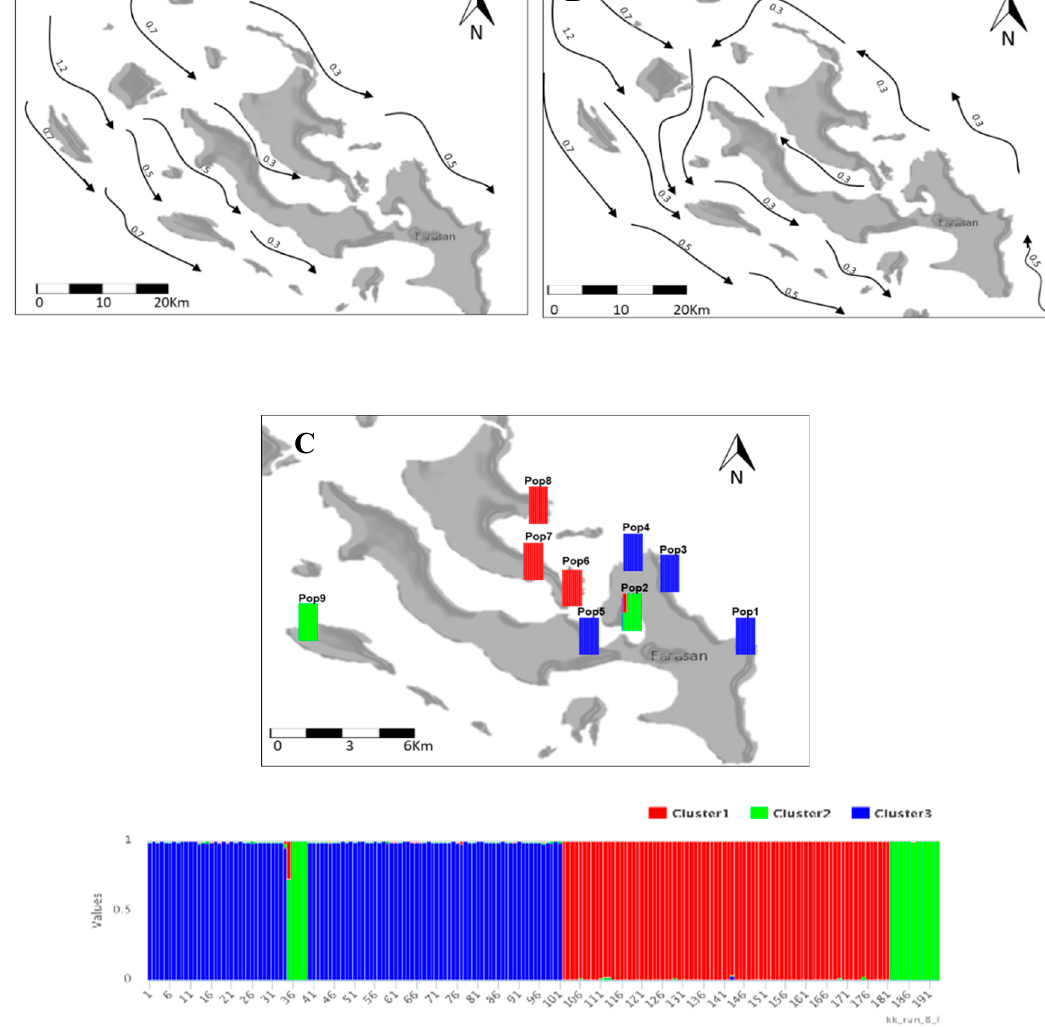
Figure 8. Maps depicting the genetic structure among populations of Avicennia marina and the sea surface circulations in the Farasan archipelago. ( A , B ) Surface current climatology from the model is shown for ( A ) the summer season ( B ) and winter season, where the number indicates the current speed in m/s. ( C ) Structure bar plots showing the assignment of individuals to three distinct genetic clusters (K = 3).